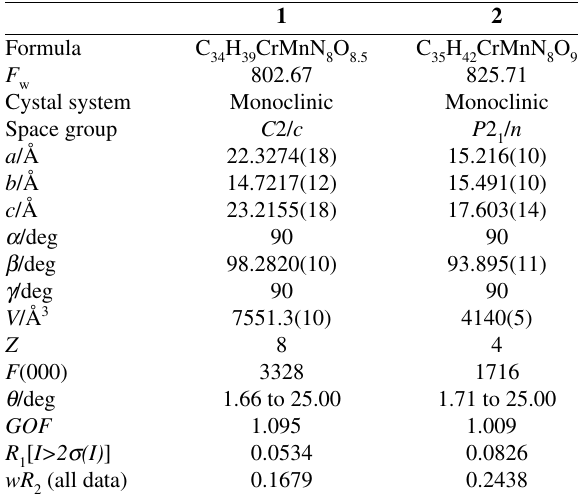
Ta ble 1. Crystallographic data for complexes 1 and 2